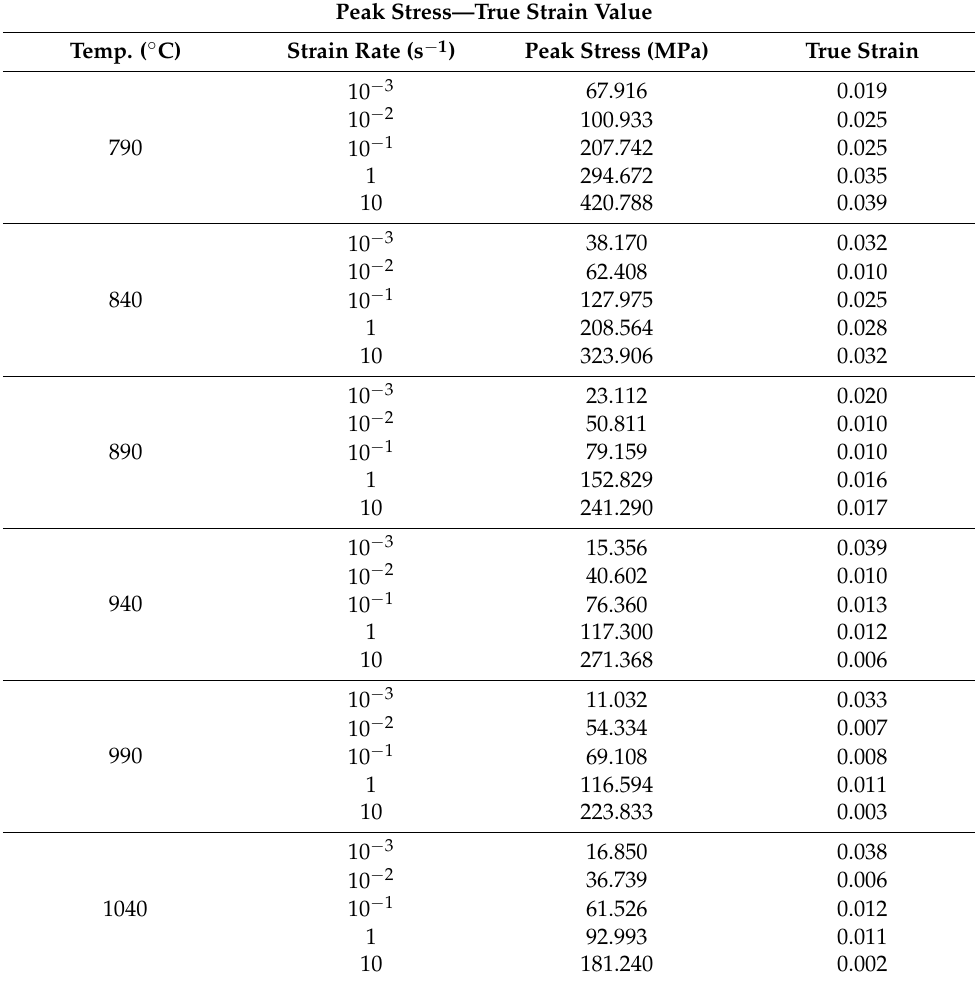
Figure 3. ( a ) Effect of change in temperature on peak flow stress of Ti6Al4V-5Cu alloy at various strain rates 10 − 3 –1 s − 1 ; ( b ) effect of strain rate on peak flow stress in the temperature range of 790–1040 ◦ C. Table 1. Peak stress (in MPa) and corresponding true strain (in mm/mm) of Ti6Al4V-5Cu alloy hot compressed at various deformation temperatures and strain